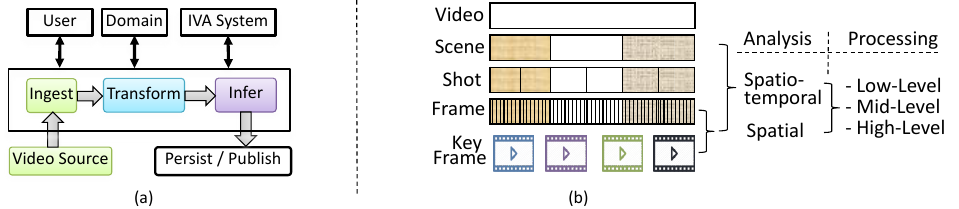
Figure 2. ( a ) A generic Intelligent Video Analytics (IVA) pipeline. ( b ) Hierarchical representation of video